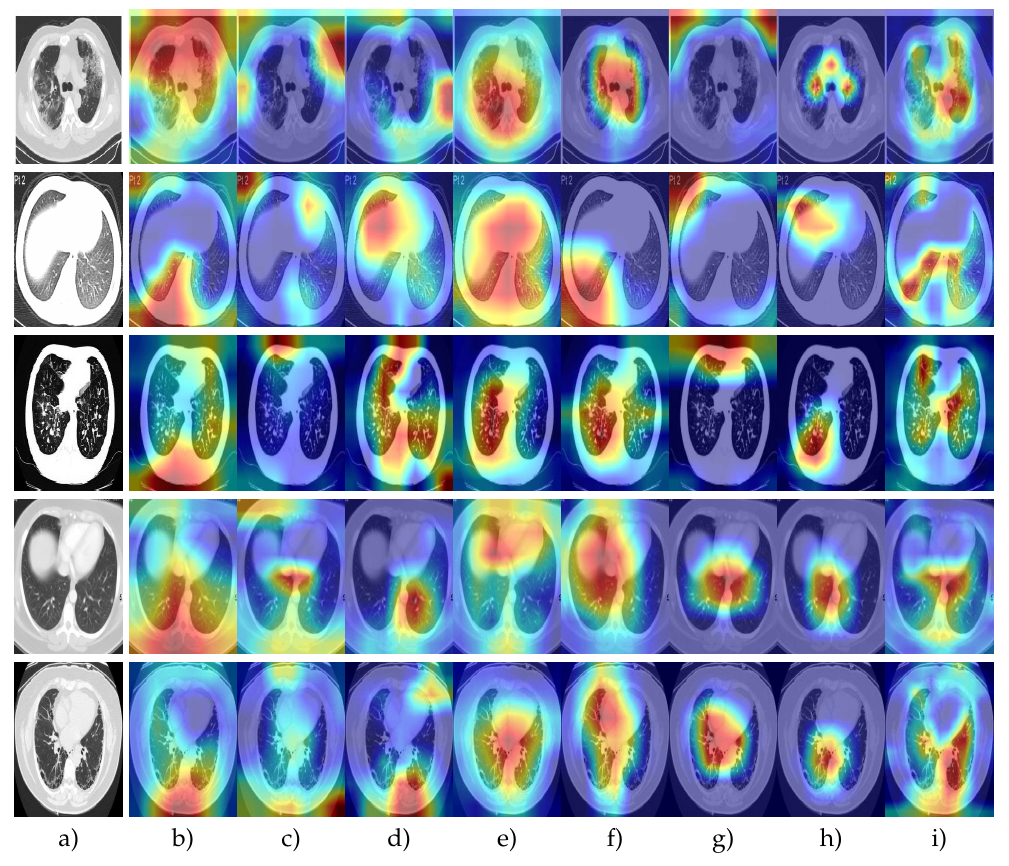
Figure 12. Representative images from COVID-CT to show the algorithm focus areas. The red color shows the focus of the network. The first three rows of images are of cases with COVID-19, while the last two rows of images are COVID-19-free. ( a ) Input images. ( b ) Alexnet. ( c ) VGG. ( d )